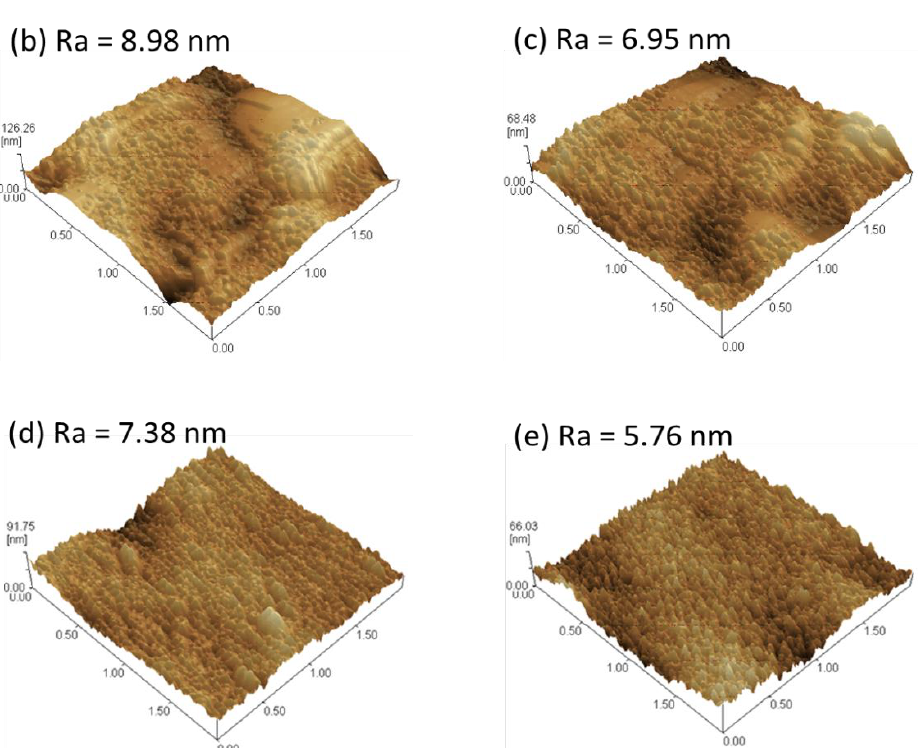
Figure 4. Atomic force microscopy images of uncoated titanium surface ( a ) and DLC film-coated titanium deposited at CH 4 /H 2 = 1:1 ( b ); CH 4 /H 2 = 1:1 ( c ); CH 4 /H 2 = 1:0 ( d ); CH 4 /H 2 = 1:0 ( e ), with the deposition times of 6 h, 12 h, 6 h and 12 h, respectively.